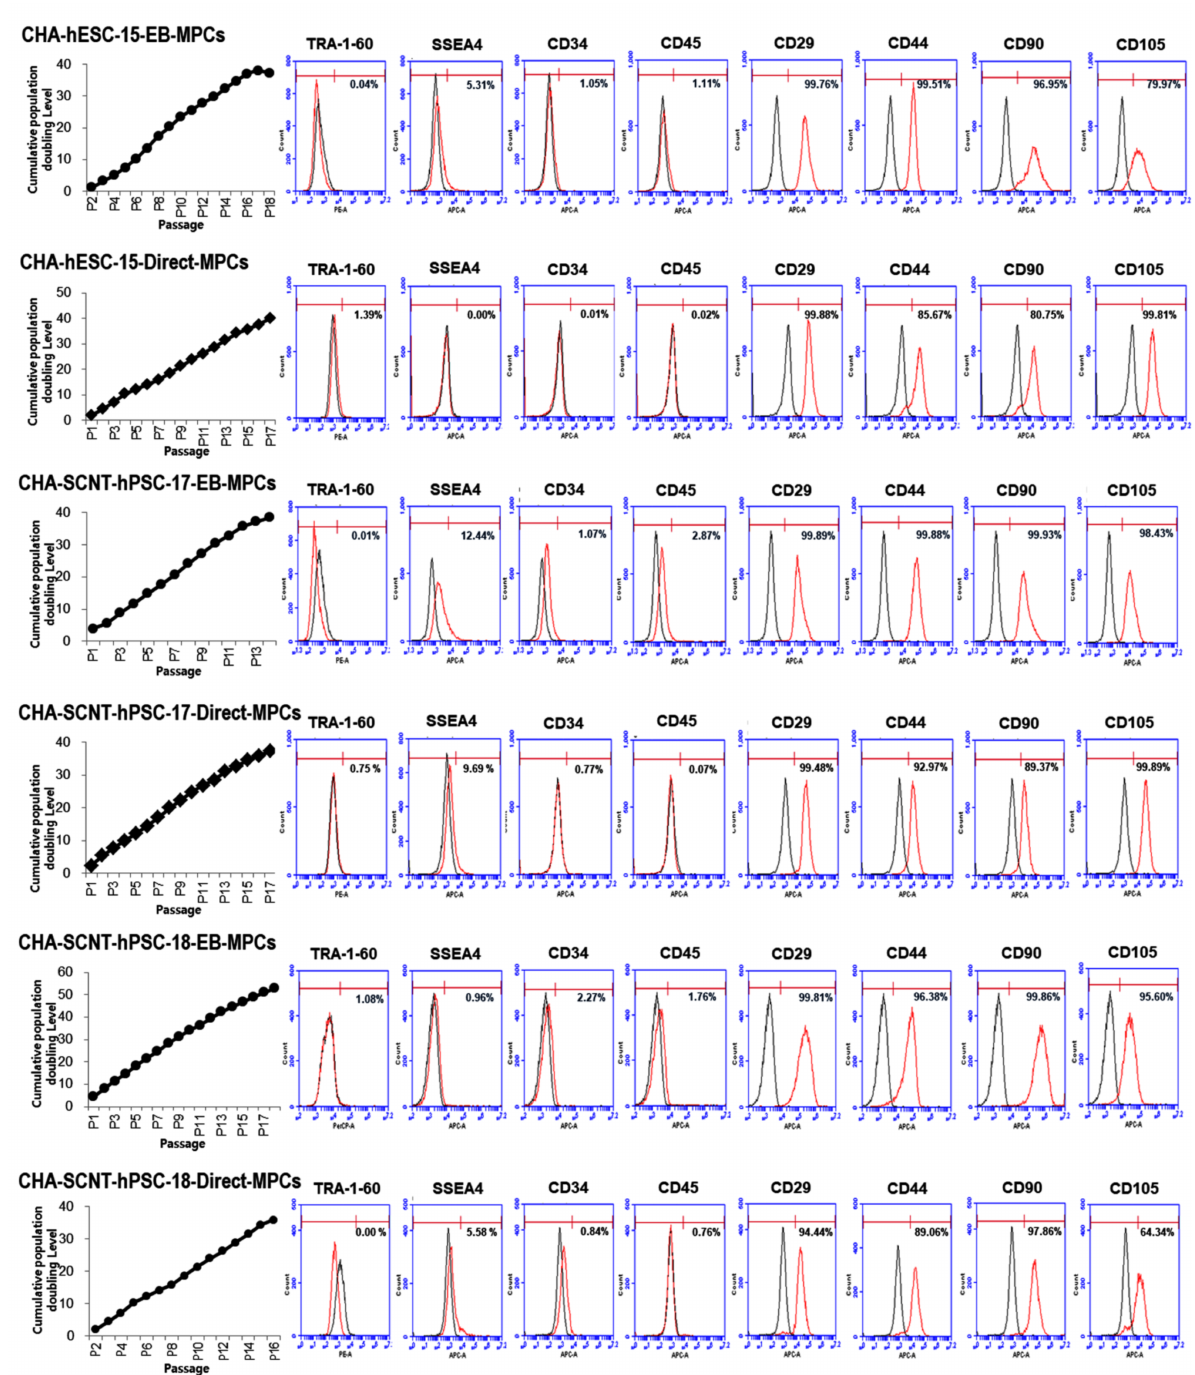
Figure 2. Cumulative population doubling level (CPDL) and expression of surface antigen profiles of hPSC-MPCs. Human PSC-derived MPCs were seeded at 4 × 10 5 cells per 75 cm 2 culture flask and counted and passaged when they were 80–90% confluent (approximately 5 days after plating). The proliferative capacities of the hPSC-MPCs are expressed as CPDL on the basis of the formula CPDL = ln(Nf/Ni)ln2, where Ni and Nf are the initial and final cell numbers, respectively, and ln refers to the natural logarithm. Surface antigen expression in hPSC-MPCs (passages 5 and 6) as determined by FACS showed that the markers for MPCs (CD29, CD44, CD90, and CD105) were highly expressed in both EB-MPCs and D-MPCs, but neither pluripotent stem cell markers (TRA-1-60 and SSEA4) nor hematopoietic markers (CD34 and CD45) were highly